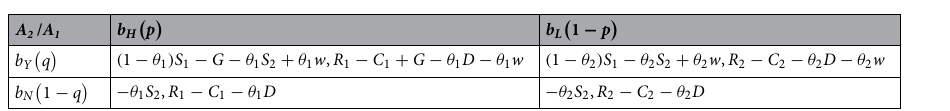
Table 2. Game payment matrix between government (A 1 ) and assembly steel plant (A 2